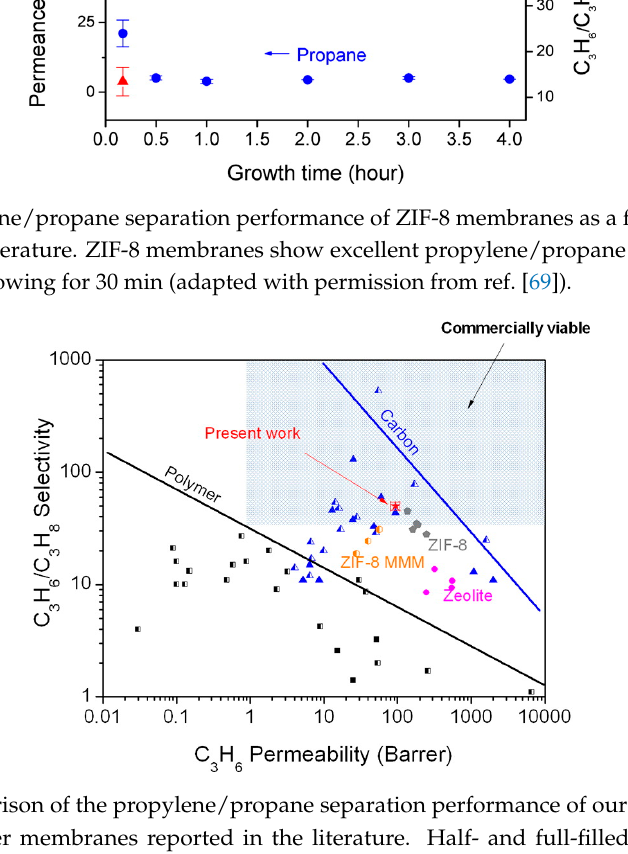
Figure 64. Comparison of the propylene/propane separation performance of our ZIF-8 membranes with those of other membranes reported in the literature. Half- and full-filled symbols indicate separation data from single and binary gas permeation measurements, respectively. The shaded area in the graph implies the performance requirement of a membrane (a minimum permeability of 1 bar and a selectivity of 35) for commercial application. The solid lines are the so-called Robson upper bound, the triangle is the carbon membrane, the circle is a zeolite membrane, the rectangle is a polymer membrane, the pentagon is a ZIF-8 membrane, the hexagon is a ZIF-8 mixed matrix membrane, and the star is the ZIF-8 membrane in this work (adapted with permission from ref. [69]).